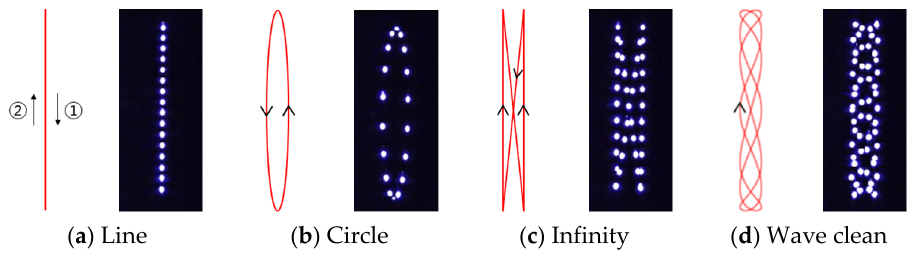
Figure 3. Schematic of the laser beam scanning direction and high-speed camera photography based on beam scanning patterns; ( a ) Line, ( b ) Circle, ( c ) Infinity, ( d ) Wave clean.